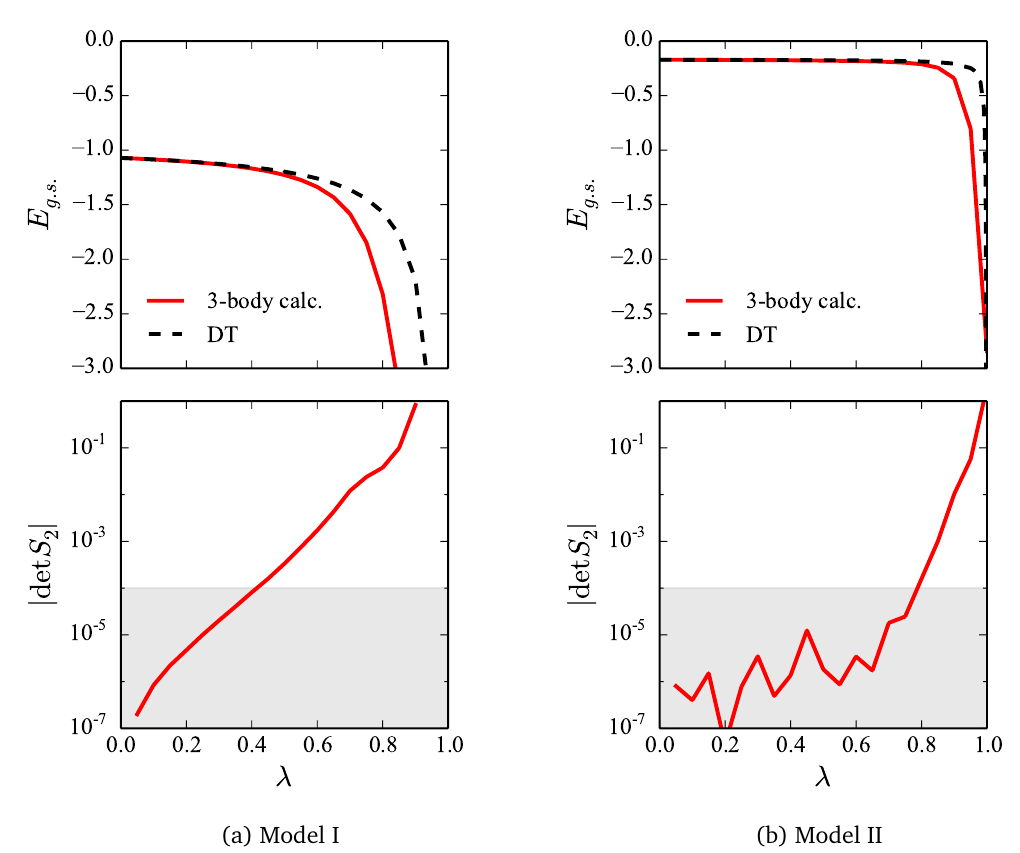
Figure 4: (Upper) Ground-state energy E lation and the DT formula. (Lower) | det S